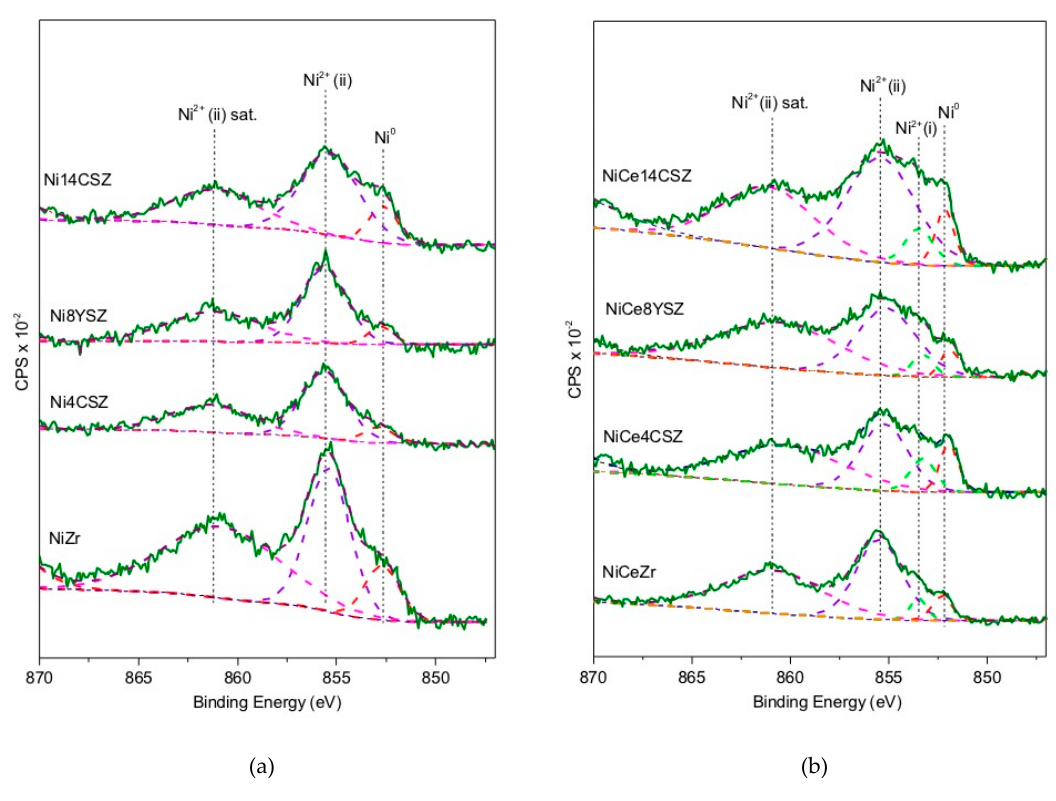
Figure 5. Nickel 2p XPS spectra: ( a ) samples without Ce; ( b ) samples with Ce.